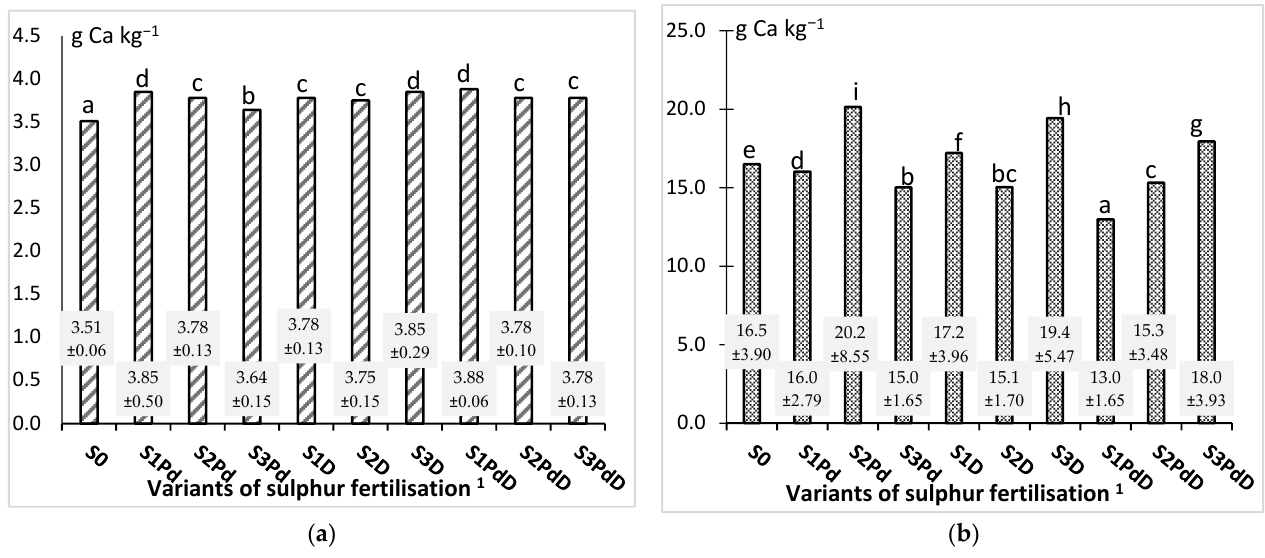
Figure 10. ( a ) Calcium content in the rape seeds on average for variants of sulphur fertilisation; ( b ) Calcium content in the rape straw on average for variants of sulphur fertilisation. 1 See Table 2; Means followed by the same letter are not statistically different at the α = 0.05 level. ± —standard deviation.